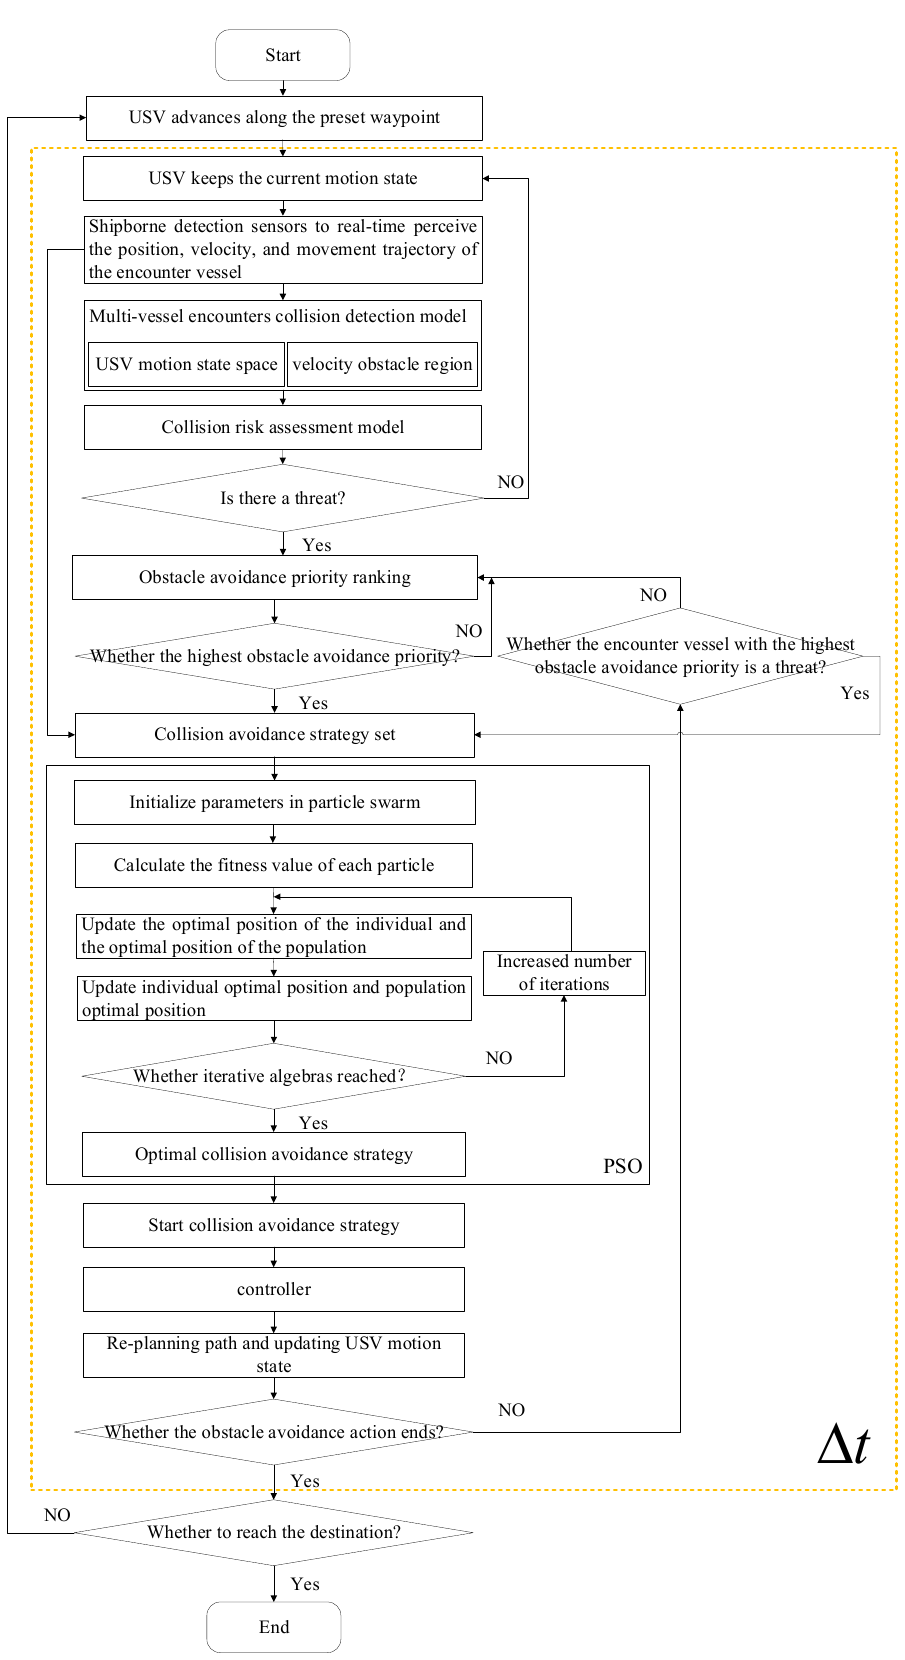
Figure 9. Implementation process of USV autonomous obstacle avoidance algorithm.